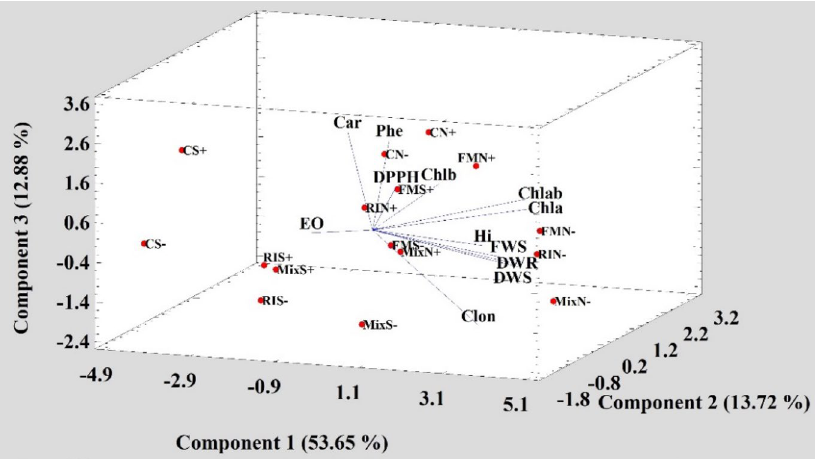
Figure 3. Principal component analysis (PCA) was performed on characteristics of Arizona cypress inoculated with Rhizophagus irregularis , Funneliformis mosseae and a mixture of both species with and without Pseudomonas fluorescens inoculation. N well watered (100% field capacity), S: water stress (50% field capacity), RI Rhizophagus irregularis , FM Funneliformis mosseae , Mix R. irregularis – F. mosseae mixture, + Pseudomonas fluorescens inoculation, − without Pseudomonas fluorescens inoculation, C non-inoculated plants, Hi: Plant height, FWS shoot fresh weight, DWS shoot dry weight, DWR root dry weight, EO essential oil content, Phe total phenolic contents, Clon root colonization, Chla Chlorophyll a , Chlb chlorophyll b , Chlab total chlorophyll, Car